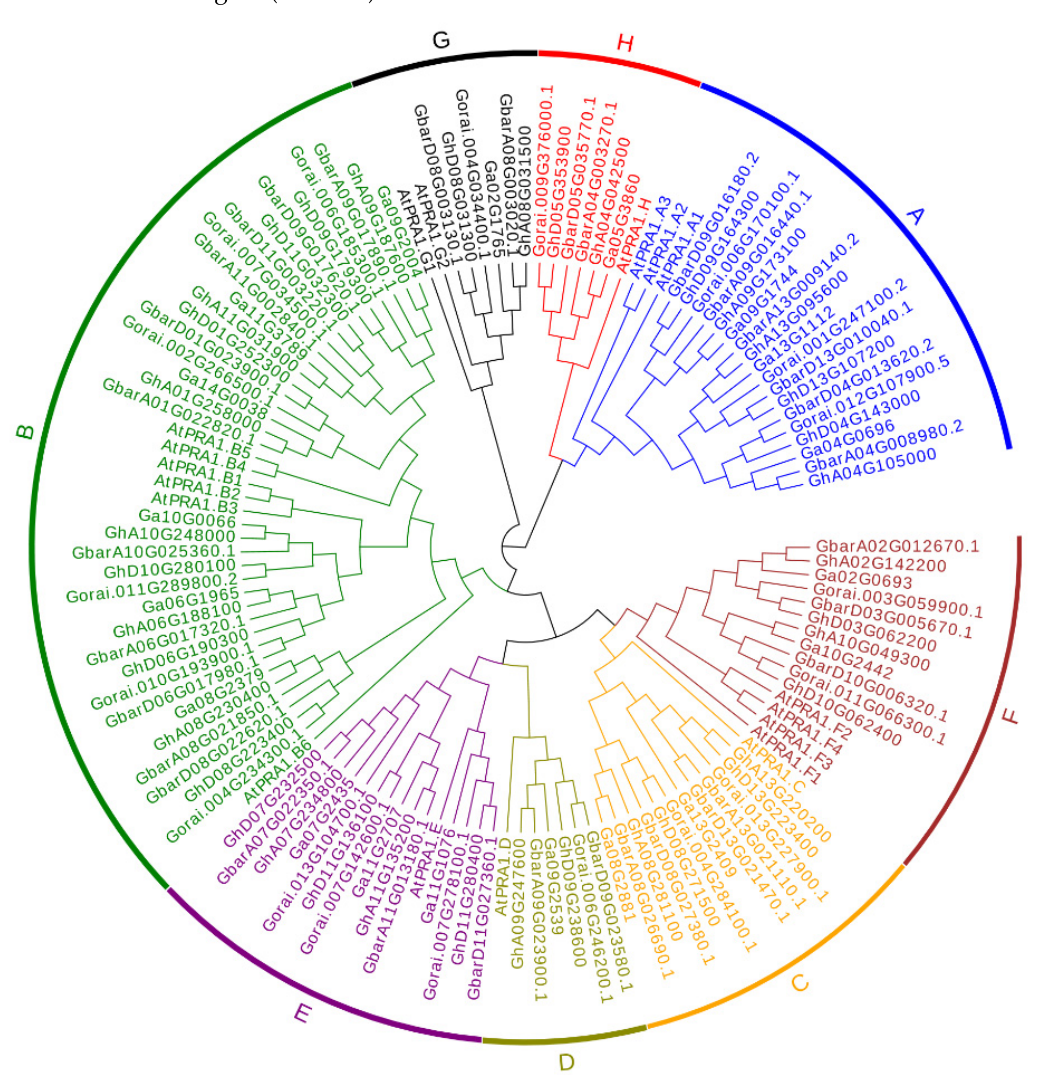
Figure 1. Phylogenetic analysis of the PRA1 gene family. At, A. thaliana ; Ga, G. arboreum ; Gr, G. raimondii ; Gb, G. barbadense ; Gh, G. hirsutum .